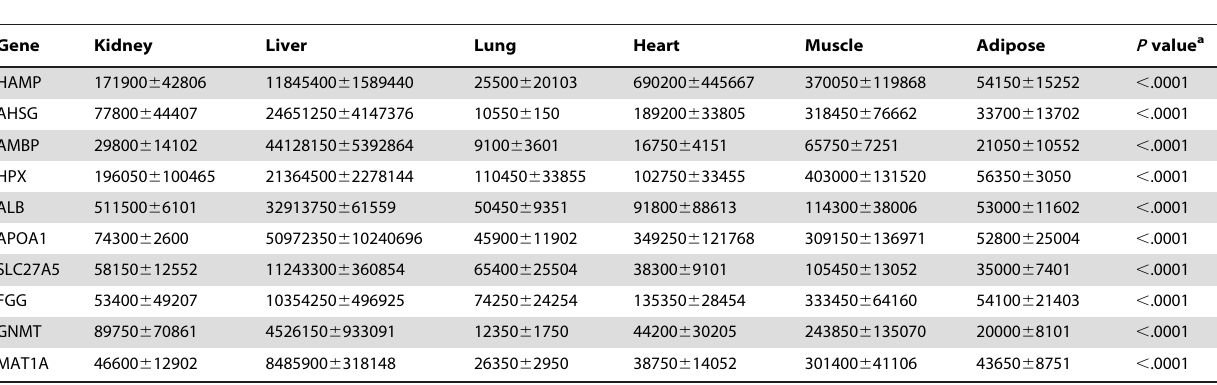
Table 4. Human liver-specific gene expression